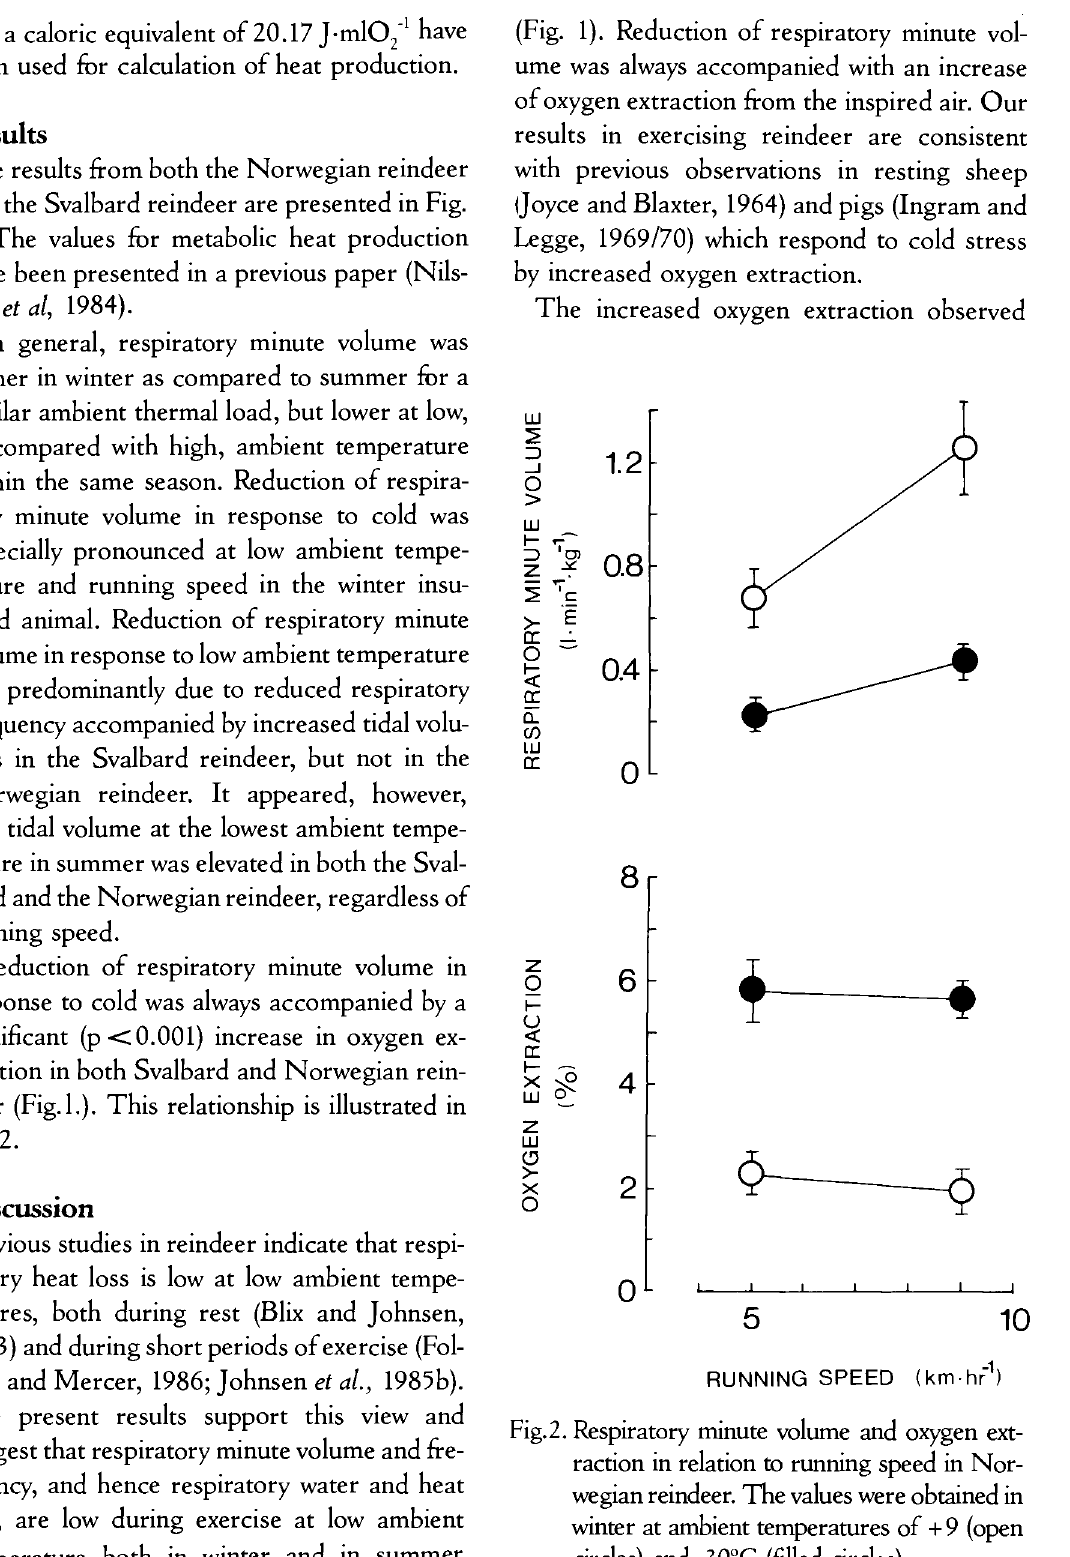
Fig.2. Respiratory minute volume and oxygen ext raction in relation to running speed in Nor wegian reindeer. The values were obtained in winter at ambient temperatures of + 9 (open circles) and -30°C (filled